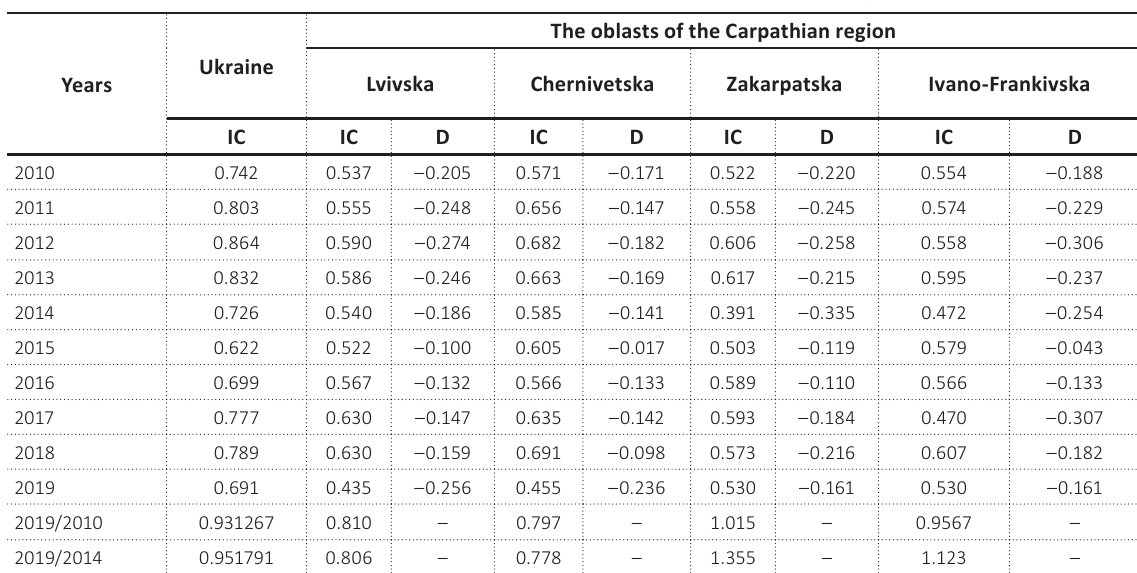
Table 4. Integral coefficients of the population’s social resilience environment in the Carpathian region and Ukraine,